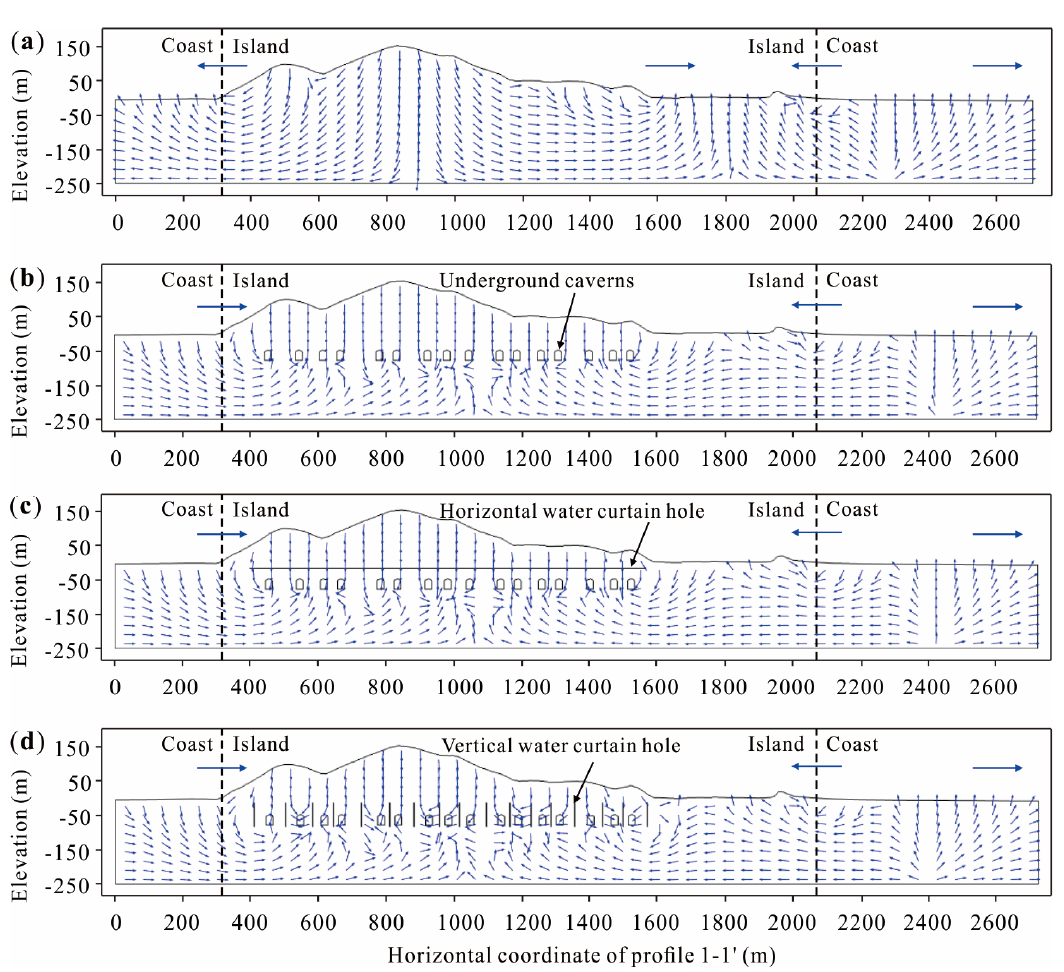
Figure 8. Groundwater seepage direction: ( a ) un-excavated; ( b ) excavated; ( c ) horizontal water curtain system; ( d ) vertical water curtain system.